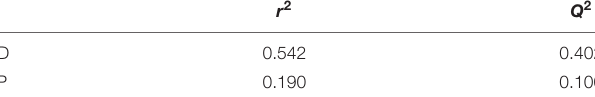
TABLE 6 | r 2 Values and Q 2 values of the variables. r 2 Q